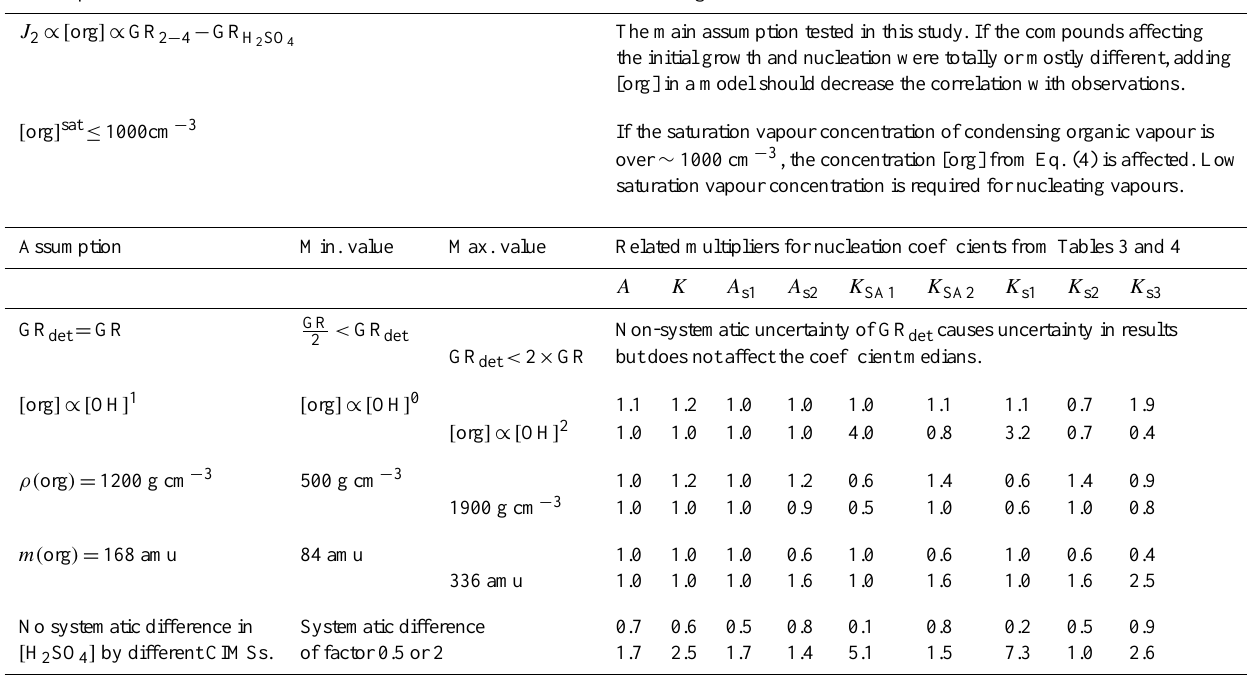
Table 5. Upper panel: the initial assumptions used in the study. Lower panel: sensitivity analysis for the nucleation coefficients when the assumed OH-dependency, density and mass of the low-volatility organic vapour are varied, and when the CIMSs are assumed to have systematic difference in measured sulphuric acid concentration. Tabulated values for nucleation coefficients represent the factors with which the median values of A and K in Table 4 and optimized coefficient values in Table 3 need to be multiplied if the corresponding minimum or maximum value is